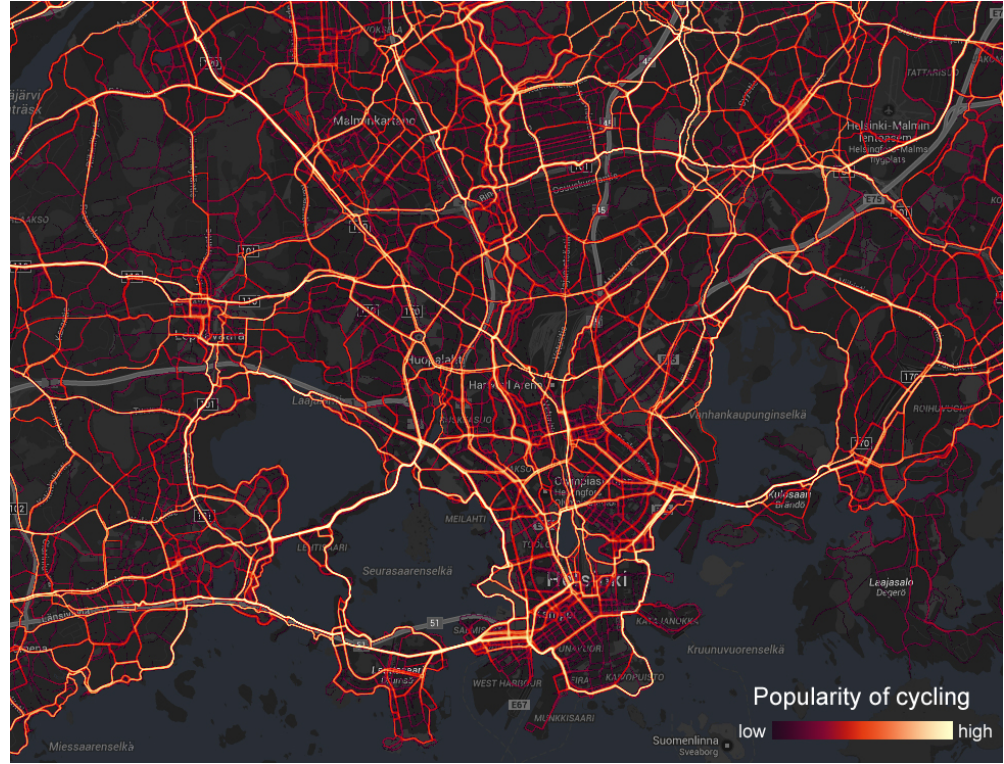
Figure 6. Heat map of popular cycling routes in